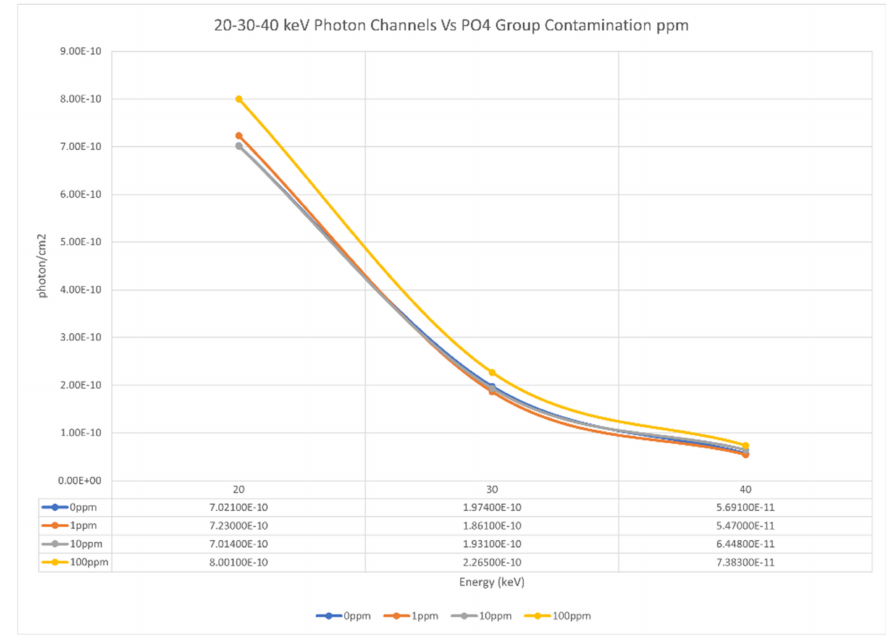
Figure 14. Medium band photon spectrum-air sample vs. contamination.